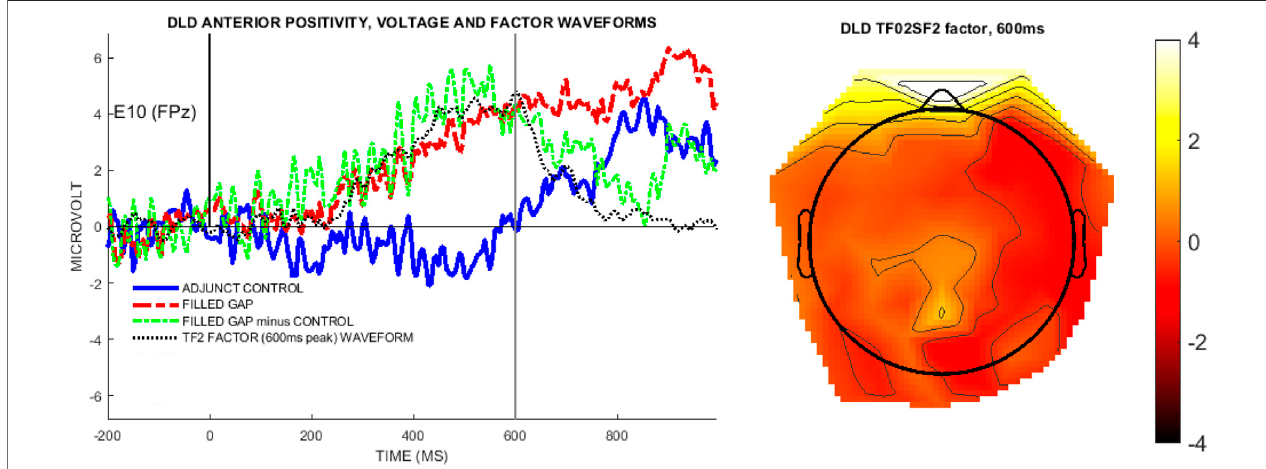
FIGURE 11 | The left panel shows the temporal factor waveform derived from the voltage difference waveform ( fi lled gap minus control), overlaid with the undecomposedvoltagewaveformsforthe fi lledgapandcontrolconditionwaveforms,forE10(FPz),thepeakpositivechannelinTF02SF2.Therighttopoplotshowsthe temporospatial factor TF02SF2 at 600 ms.